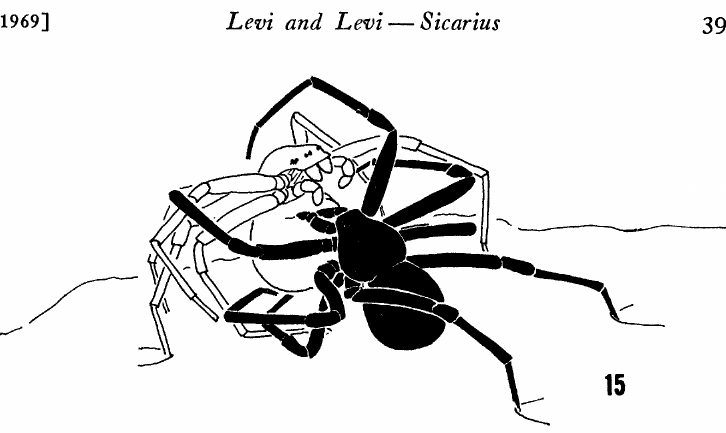
Fig. 15. 8icarius sp. mating on 13 June. The male has been illustrated black, the female white. The drawing was made from a